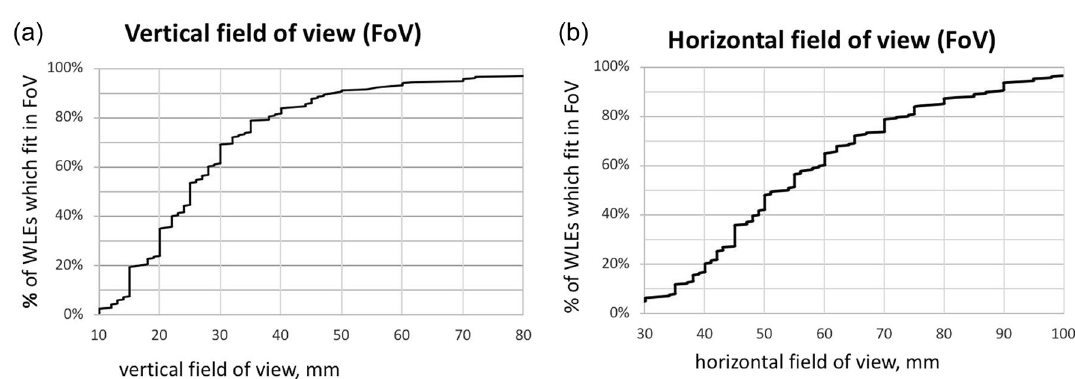
Figure 3. Size distribution of 248 consecutive WLEs examined at London’s Barts Hospital ( a , vertical; b ,